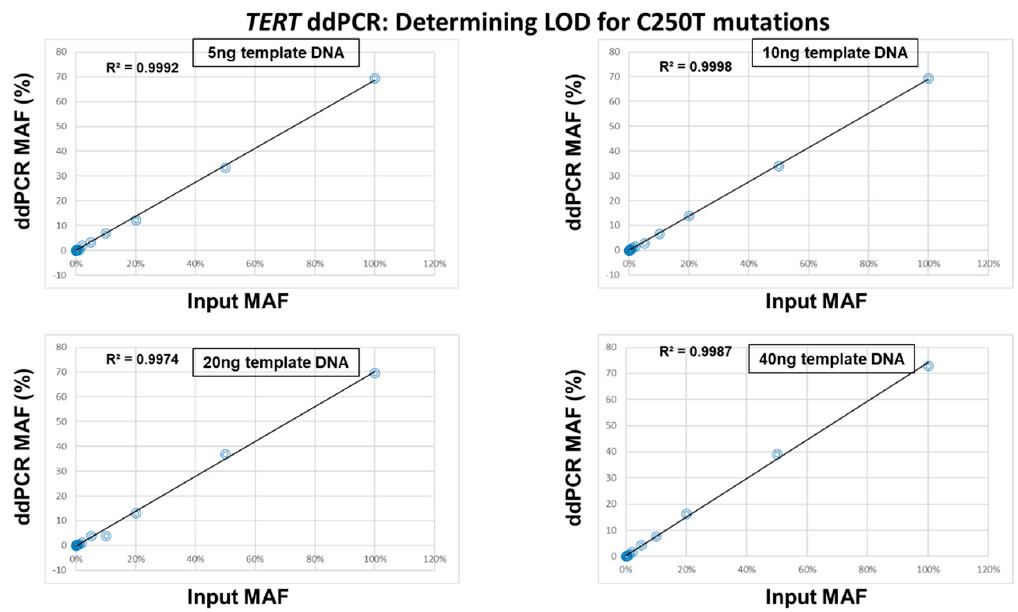
Figure 4. Linearity between the input Mutant Allelic Fractions (MAFs) and the experimentally determined MAFs for the TERT C250T assay. The theoretical percentage of the MAFs from serially diluted C250T mutated template DNA into wild-type DNA was plotted against the experimentally determined ddPCR MAFs for 5 ng, 10 ng, 20 ng and 40 ng.